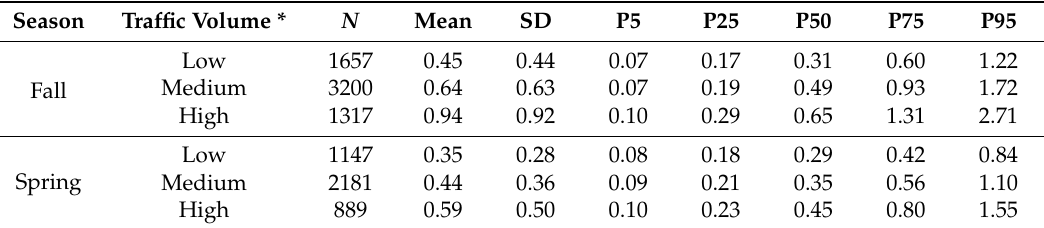
Table 1. Simple statistics of black carbon concentrations ( µ g/m 3 ).